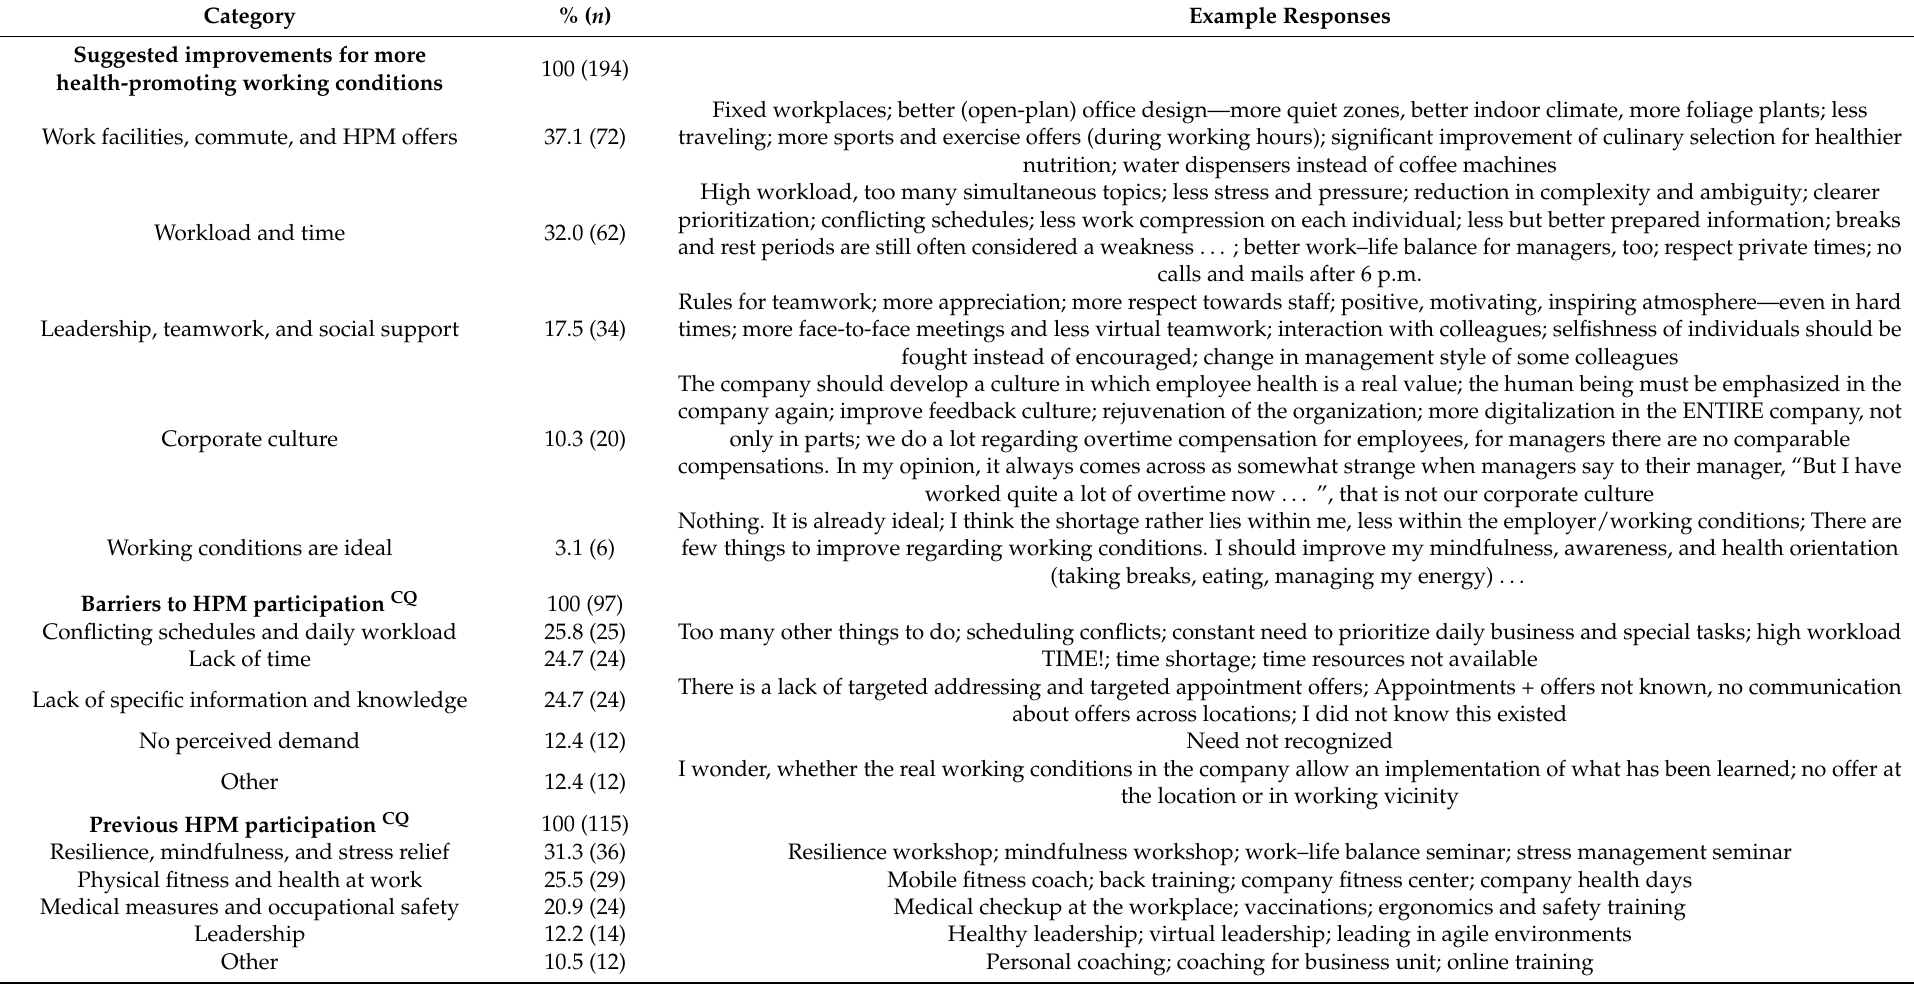
Table 3. Categories, Frequencies, and Response Examples: Managers’ Suggestions for Health-Promoting Working Conditions, Barriers to HPM Participation, and Previous HPM Participation.